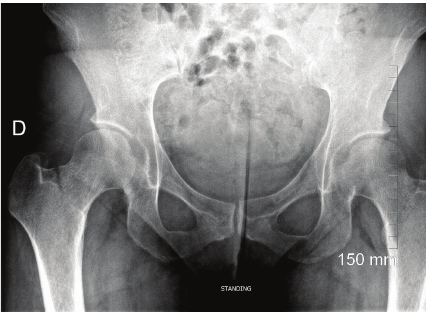
Figure 2: Pelvic X-ray, anteroposterior view. Basicervical fracture of the right